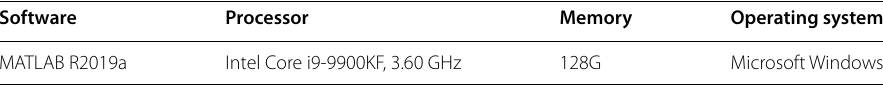
Table 2 Running environment of our experiments Software